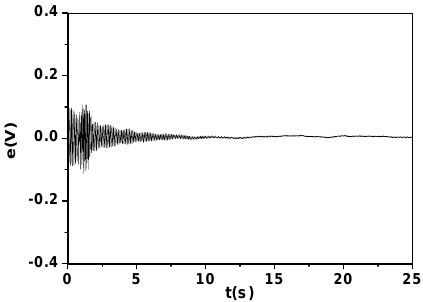
Fig. 7. Error evolution – LMS algorithm applied to case C 2 .